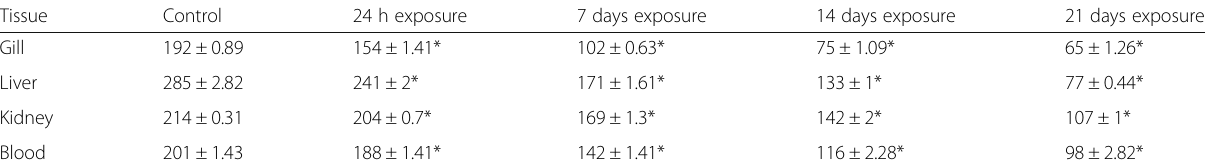
Table 7 Total DNA content (ng/ μ l) in the gill, liver, kidney, and blood in the fish Cyprinus carpio during exposure to sub-lethal con- centration of